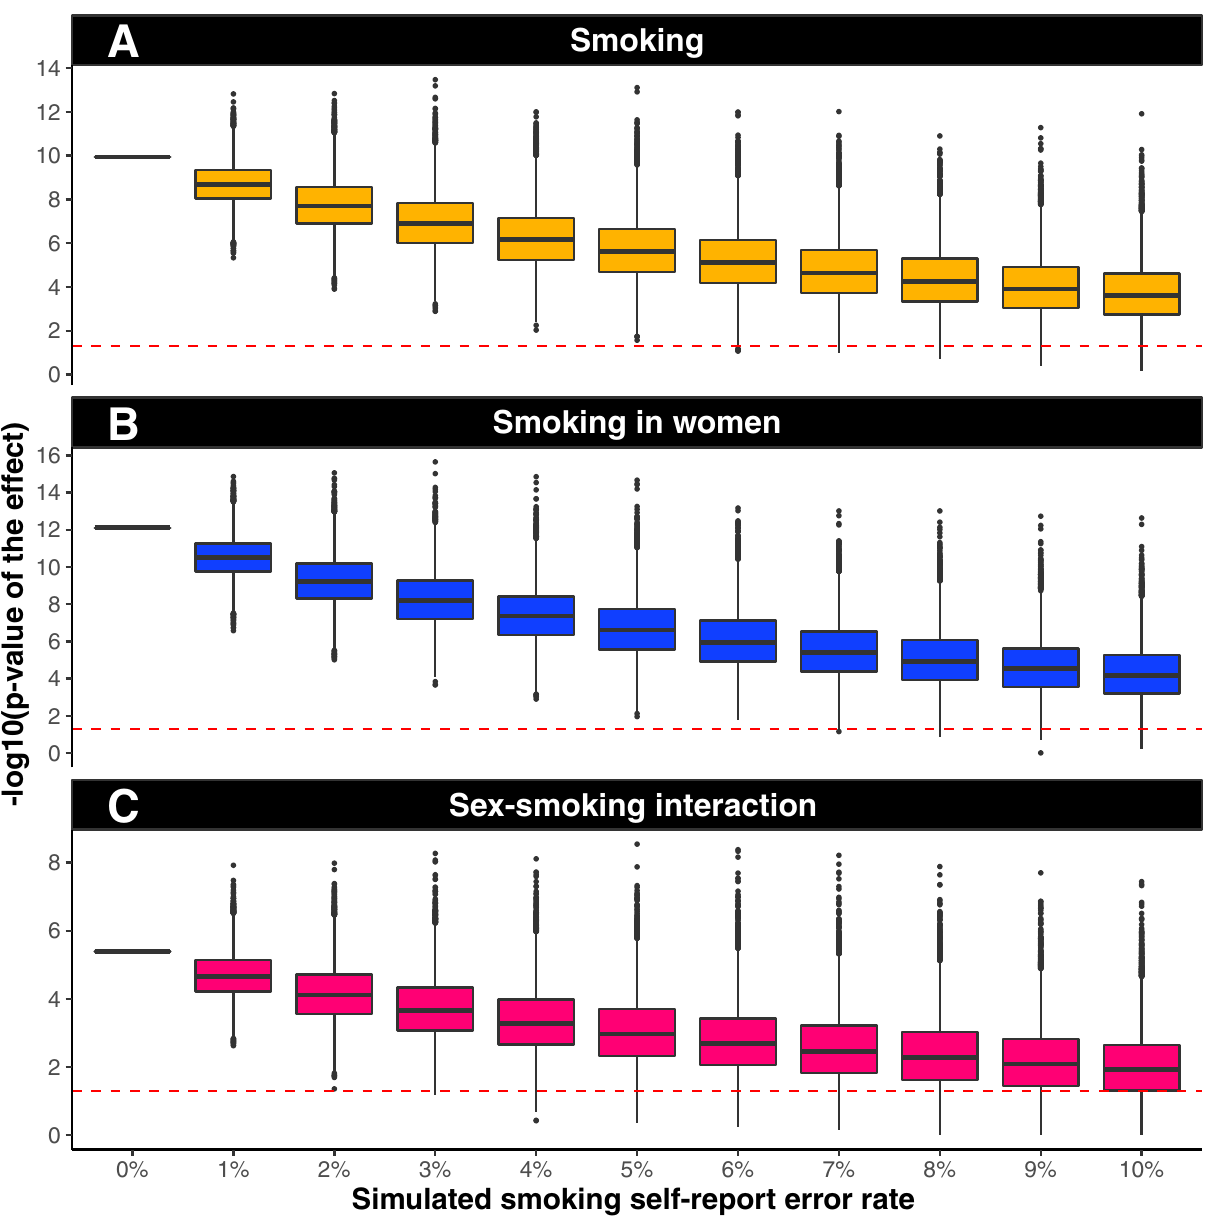
Figure 7. Artificial error introduction suggests the present smoking results are likely not due to self-report error. A Monte Carlo simulation was used to determine the effect of introducing artificial error (in addition to any real self-report error already in the data). Error was introduced in 1% increments (x-axis) by randomizing smoker status. Each box represents 10,000 model simulations, and plotted are the p-values for each simulation. The red dashed line represents a significance level of α = 0.05. At 0% simulated error, we report our measured p-value. In the whole cohort and women specifically ( A,B ), we measure a significant effect in > 90% of simulations after 10% additional self-report error is introduced. For the sex × smoking interaction term, 75% of simulations are statistically significant after 10% additional self-report error is